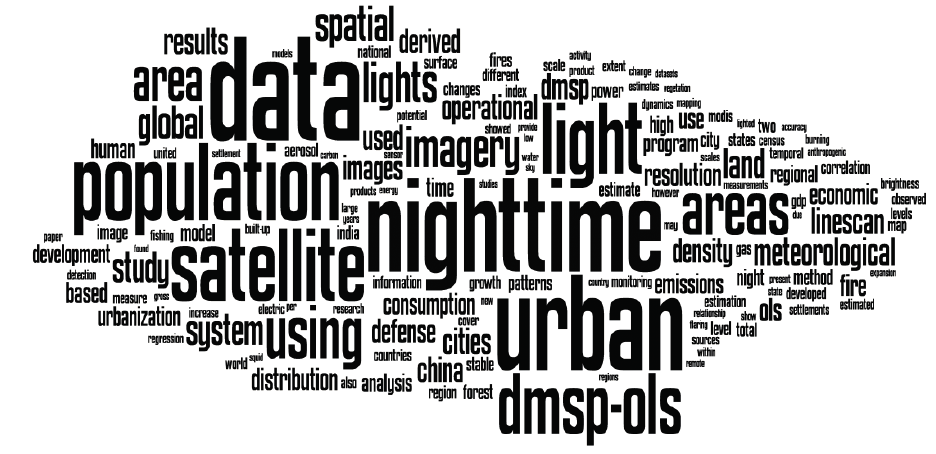
Figure 2. Word cloud generated by Wordle (http://www.wordle.net/) using words in the titles and abstracts from the selected 144 articles. The size of each word is indicative of its relative frequency of occurrence.